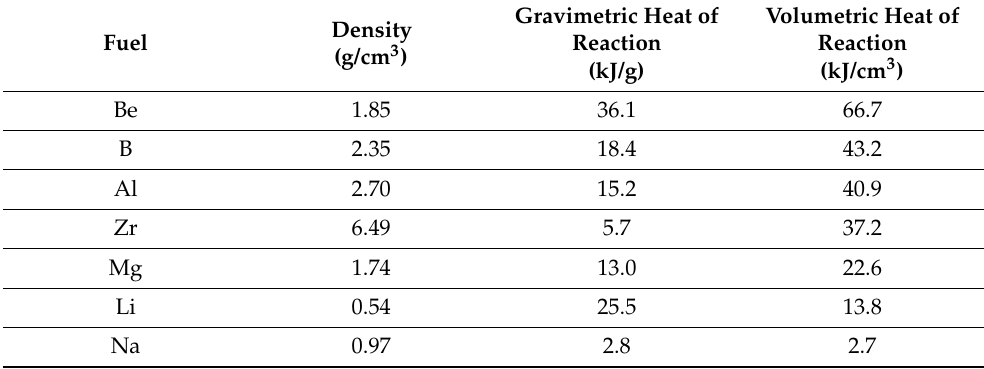
Table 1. Maximum theoretical gravimetric and volumetric heat of reaction for selected metals with liquid water, listed in the order of their volumetric heat of reaction.